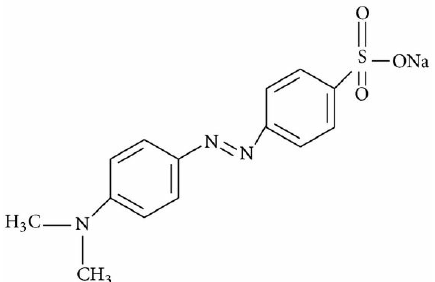
Figure 3. Methyl orange.